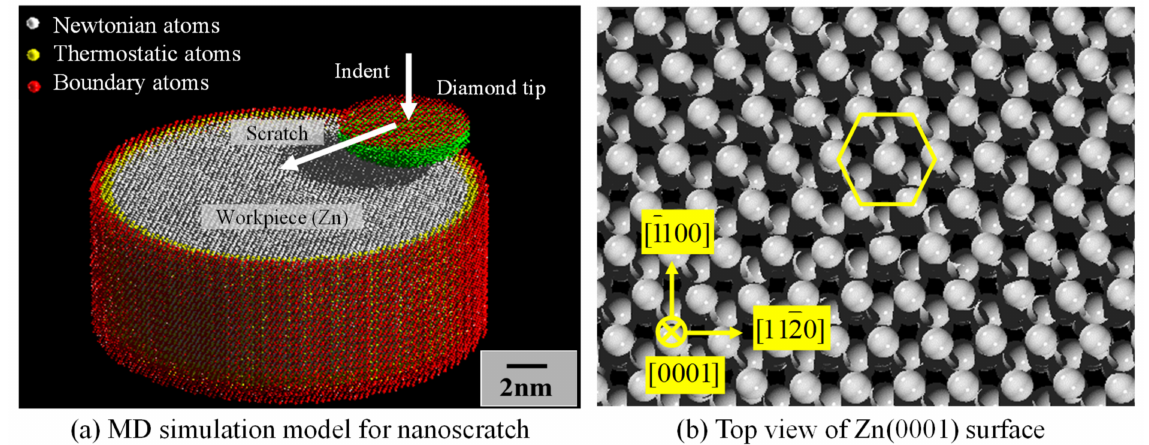
Figure 8. ( a ) MD simulation model for nanoscratch and ( b ) top view of Zn(0001)